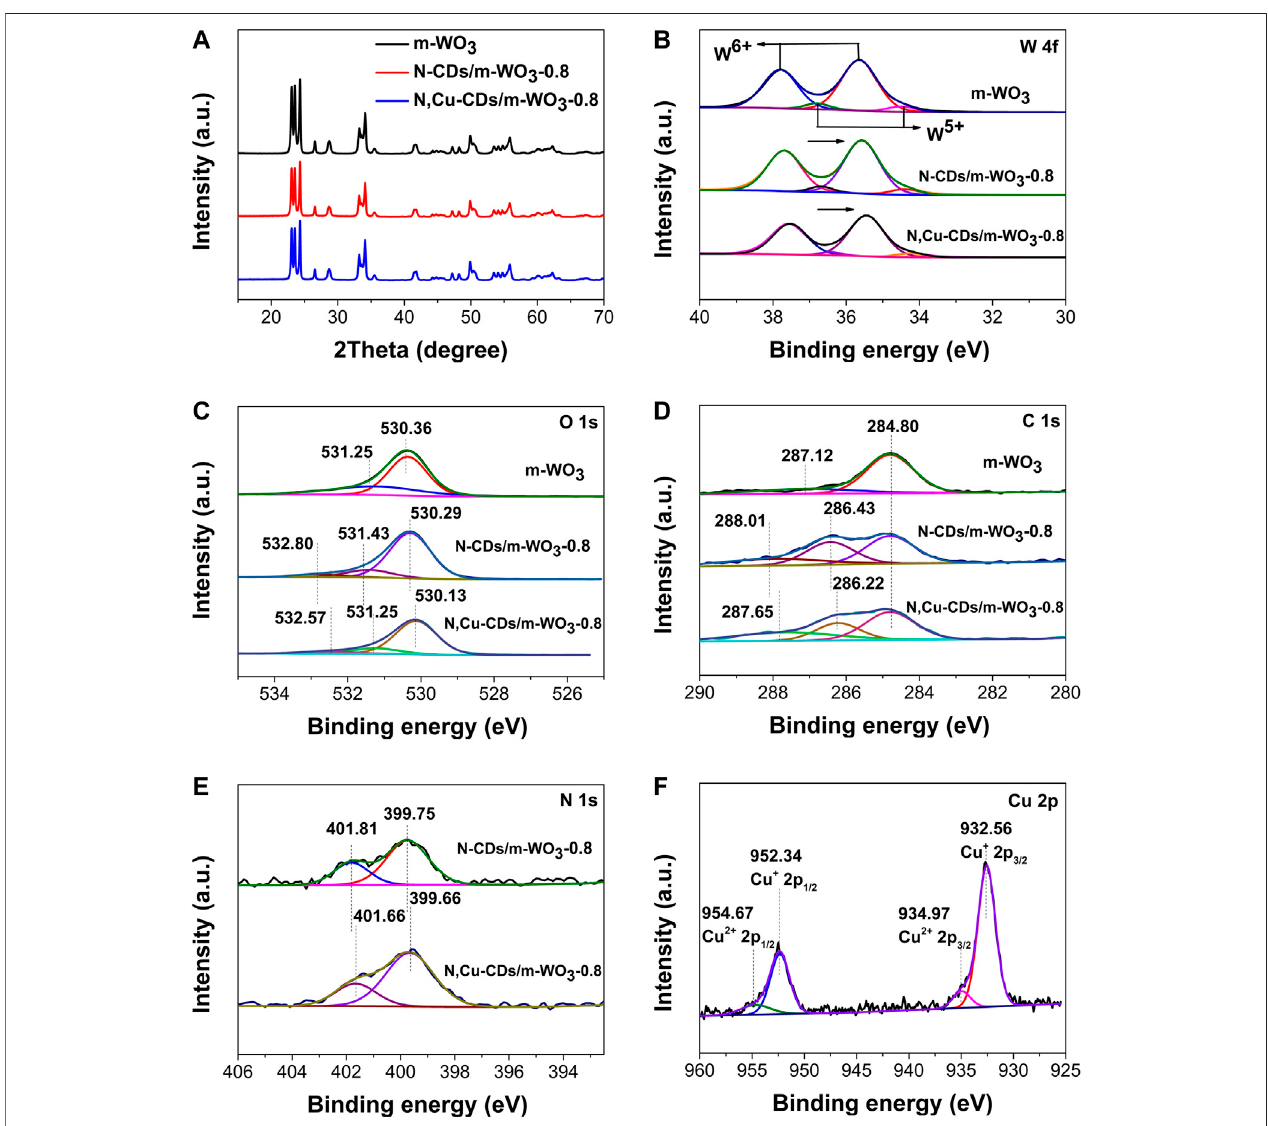
FIGURE 4 | XRD and XPS spectra of the as-synthesized samples. XRD (A) ; W 4f (B) ; O 1s (C) ; C 1s (D) ; N 1s (E) ; and Cu 2p (F) .